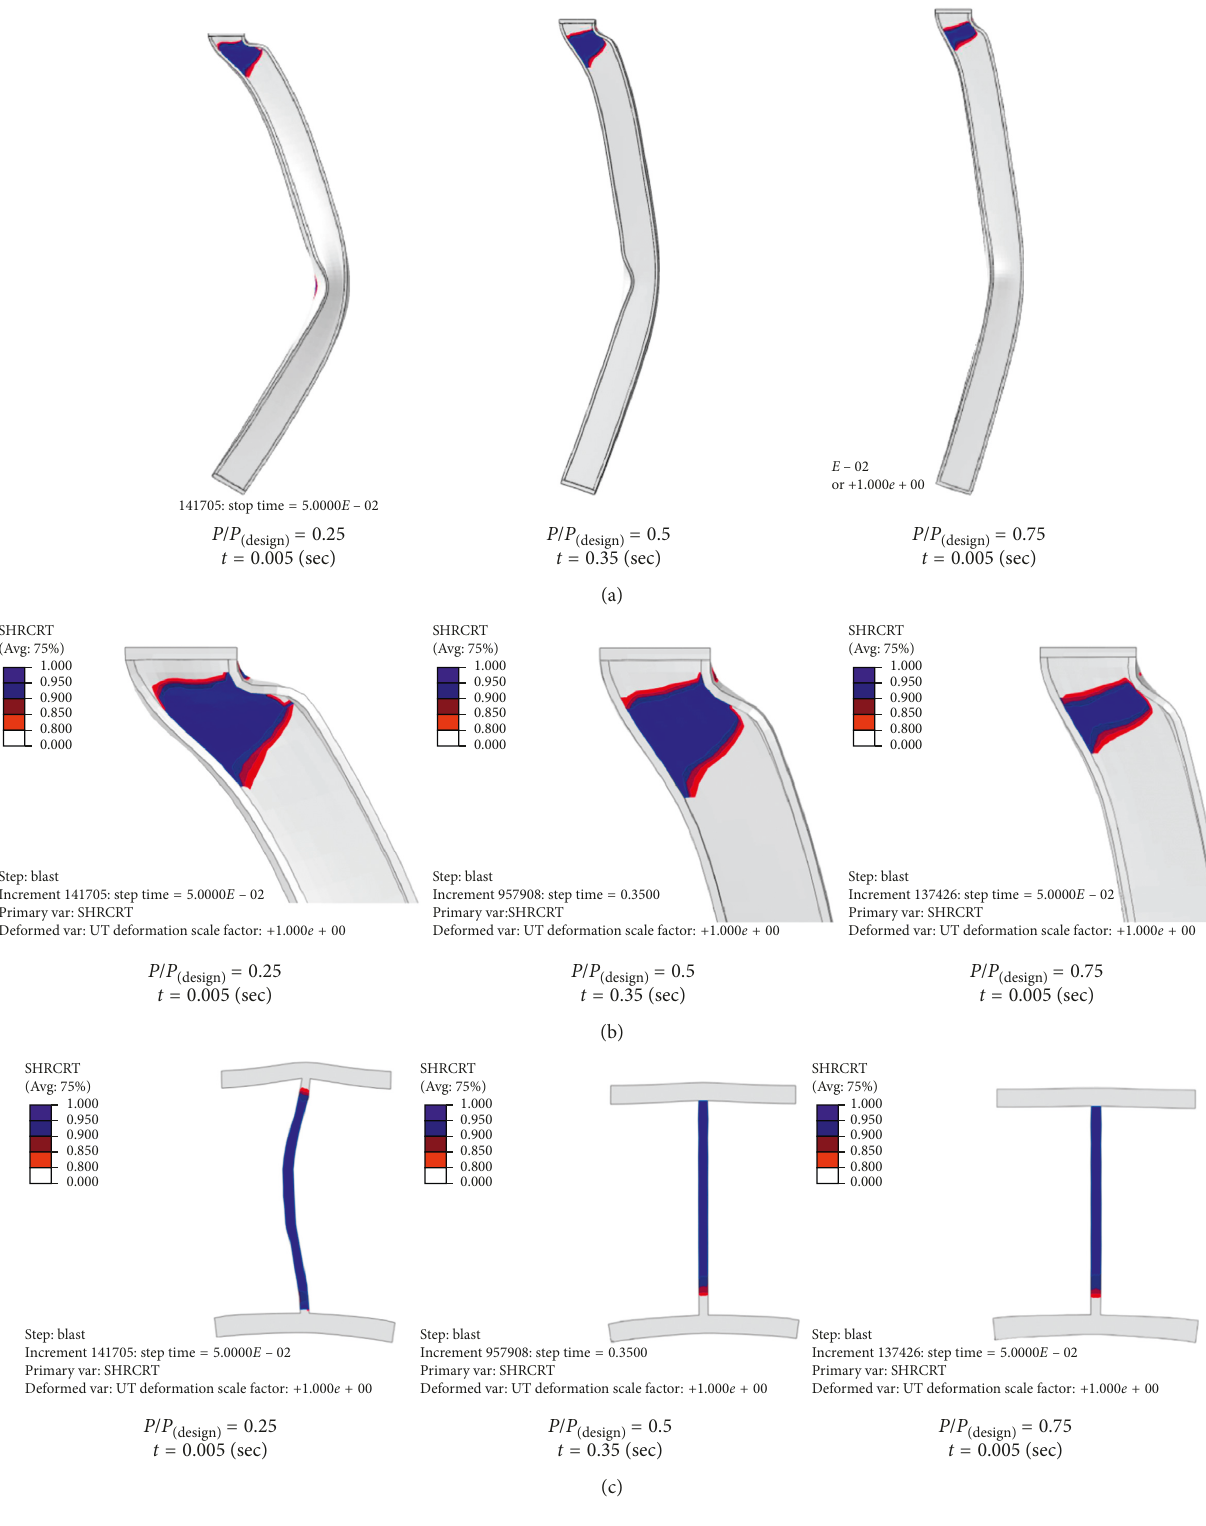
Figure 19: (a) Deformation shape and damage initiation criterion distribution along the column length for the propped cantilever column W200 71 with bending about major x - x axis. (b) A close-up view of the column at the fixed support showing. (c) A cross-sectional view of × the columns at the fixed